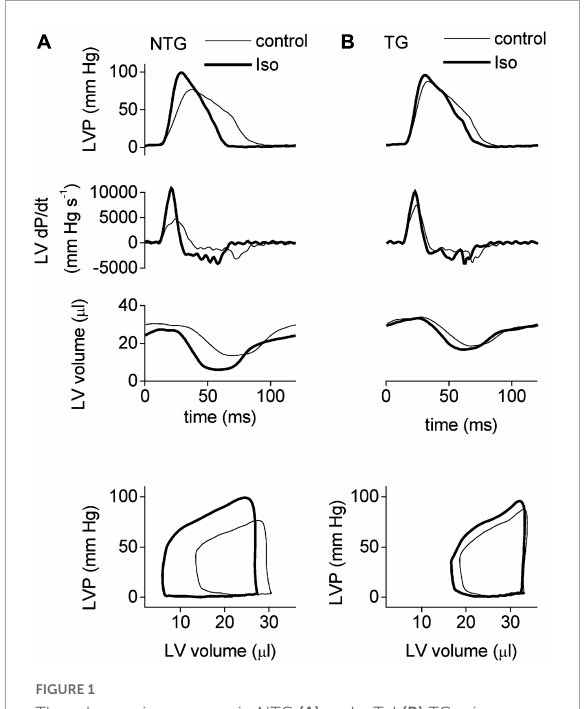
FIGURE1 The adrenergic response in NTG (A) and ssTnI (B) TG mice. Examples of LV pressure traces (top set of panels), their derivatives (second set of panels), and the corresponding LV volume (third set of panels) recorded by a Millar microconductance catheter-manometer during ejecting heart experiments at 20 cm H 2 O preload. The bottom set of panels illustrate the steady-state pressure–volume loops derived from the instantaneous LV pressure and volume traces above (first and third panels). Thin lines indicate baseline conditions and thick lines indicate the signal during stimulation with isoprenaline (10 nm). Faster relaxation in presence of Iso is apparent in NTG but the effect is suppressed In the unphosphorylatable mutant TG mouse heart. Reproduced from Layland et al. (17) with permission. © The Physiological Society